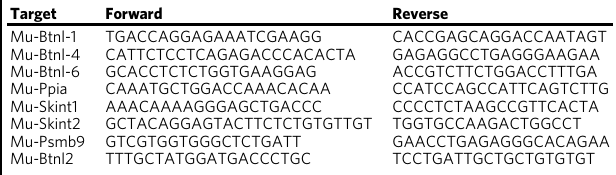
Table 1 Oligos and repair templates used for generation of fl oxed mice.